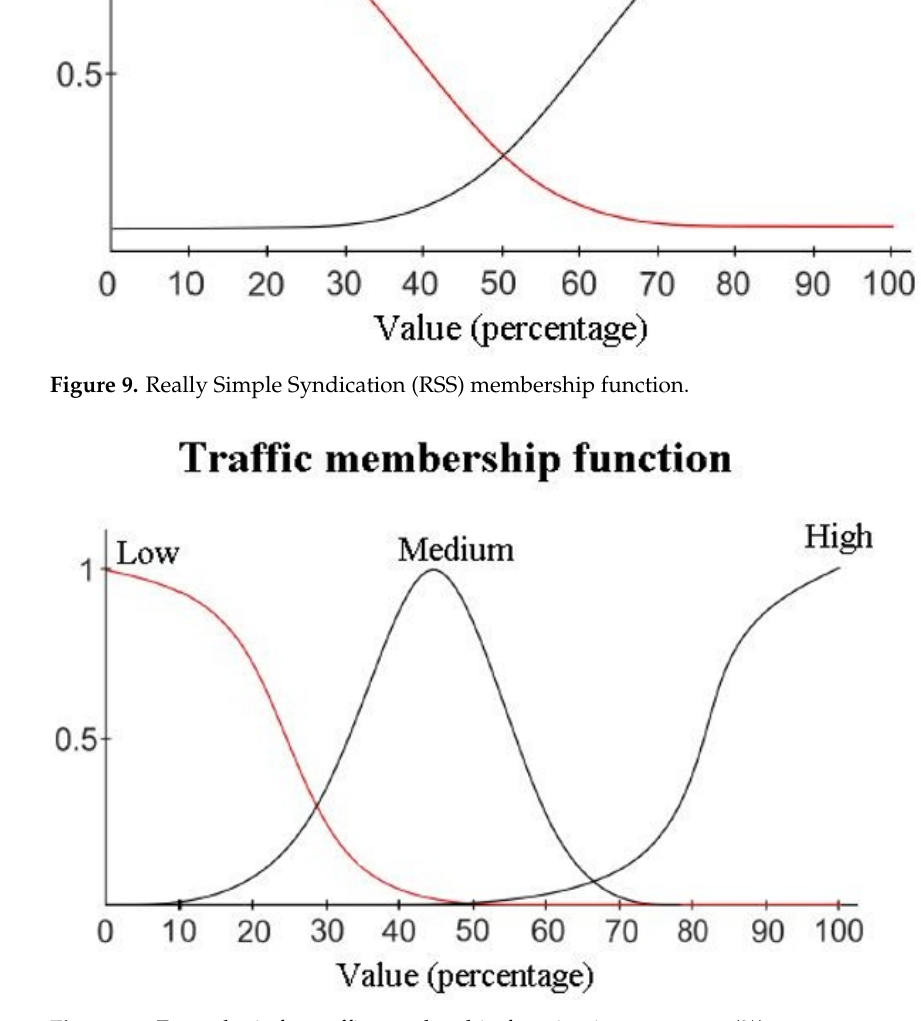
Figure 10. Fuzzy logic for traffic membership function in percentage (%).